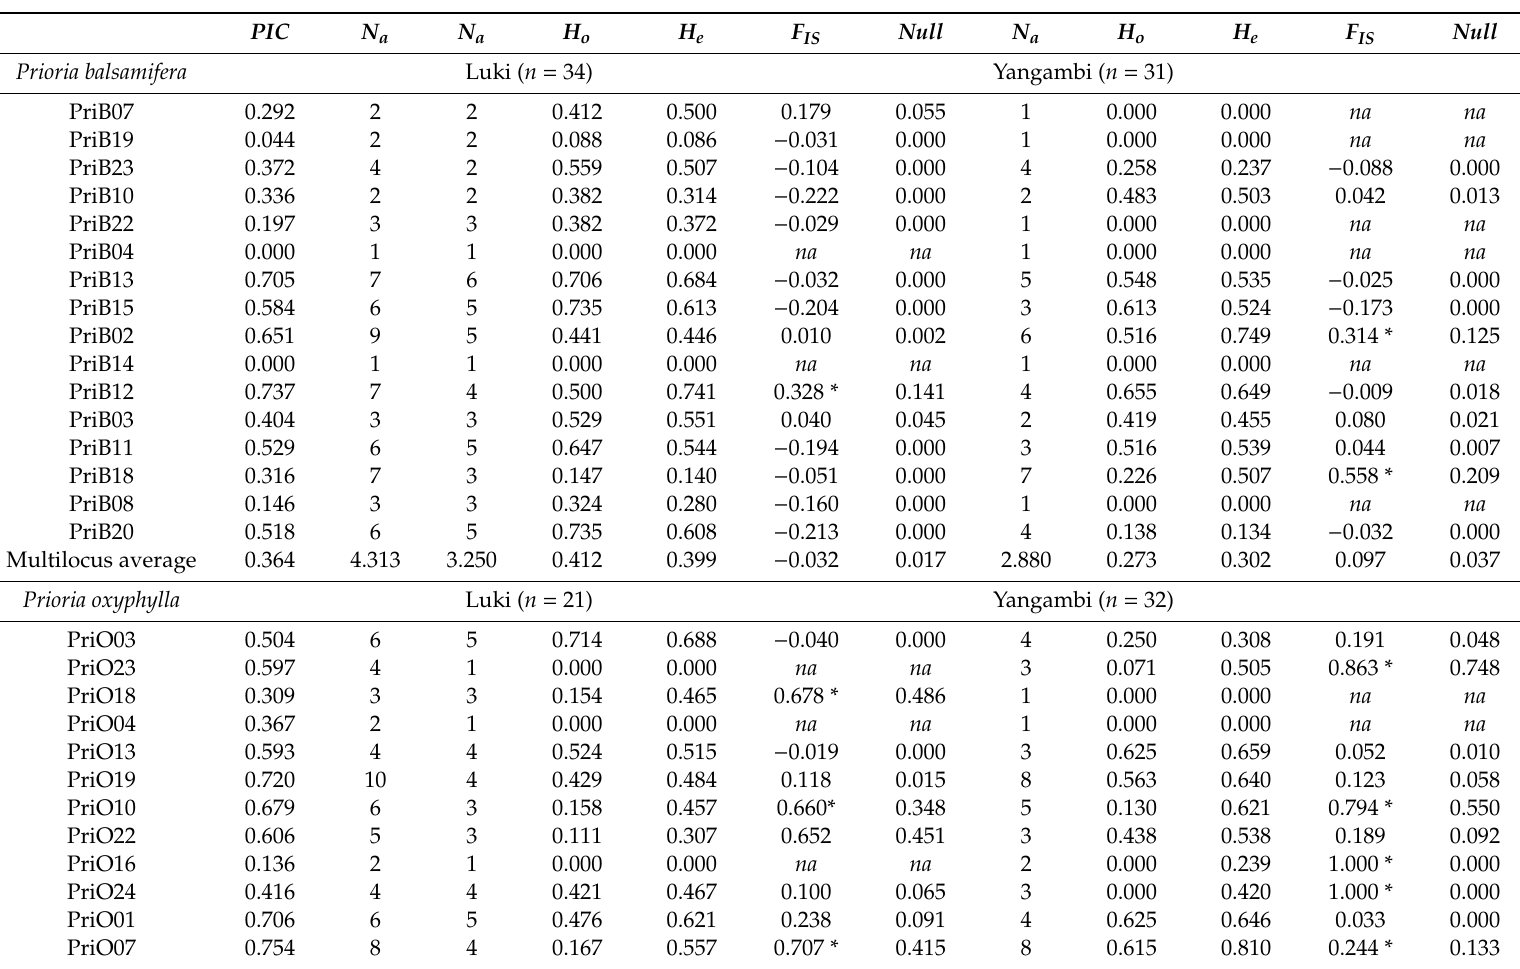
Table 2. Genetic diversity indices for two populations of Prioria balsamifera and Prioria oxyphylla using the 16 and 15 newly developed microsatellite